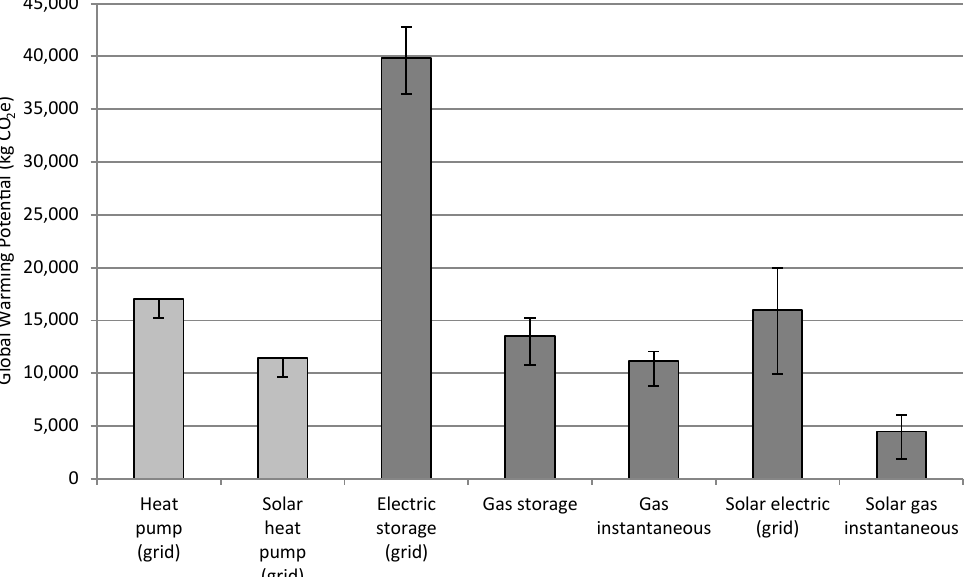
Fig. 2. Comparison of global warming potential for two heat pump systems and fi ve conventional domestic hot water systems including use phase and refrigerant losses (dark grey results from Moore et al. [3]).